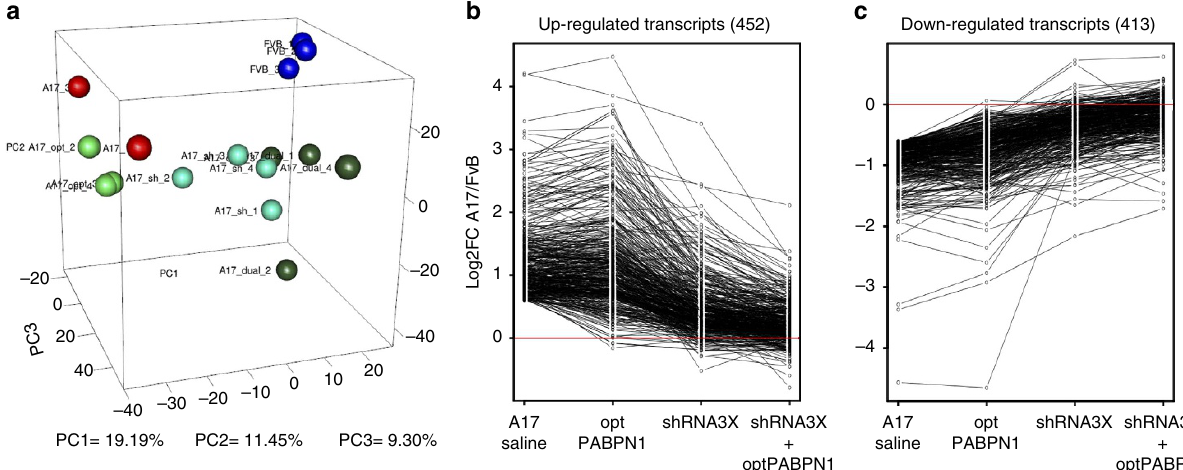
Figure 5 | Transcriptome of A17 muscles treated with the combined approach is normalized to the one of WTmice. ( a ) Principal component analysis of microarray data shows wide segregation of 30-week-old A17 mice clusters (in red) away from wild-type FvB mice clusters (in blue). Muscles treated with combined AAVs (shRNA3X and optPABPN1, in dark green) clustered very close to wild-type mice, while muscles treated with shRNA3X only (in light blue) clustered closer to FvB muscles than optPABPN1-injected muscles (light green). ( b , c ) Fold change in log2 (log2FC) of upregulated and downregulated genes in A17-treated groups compared to FvB. The treatments (A17 saline versus FvB, optPABPN1 versus FvB, shRNA3X versus FvB or shRNA3X þ optPABPN1 versus FvB) are indicated under the graph. In A17 saline compared to FvB, 452 and 413 genes were up- and downregulated respectively. Ninety-eight per cent of these dysregulated (either up- or downregulated) transcripts showed a complete return to normal expression after the gene therapy treatment. n ¼ 3 (A17 and FvB injected with saline and A17 injected with optPABPN1) or n ¼ 4 (A17 injected with shRNA3X and A17 injected with shRNA3X þ optPABPN1).